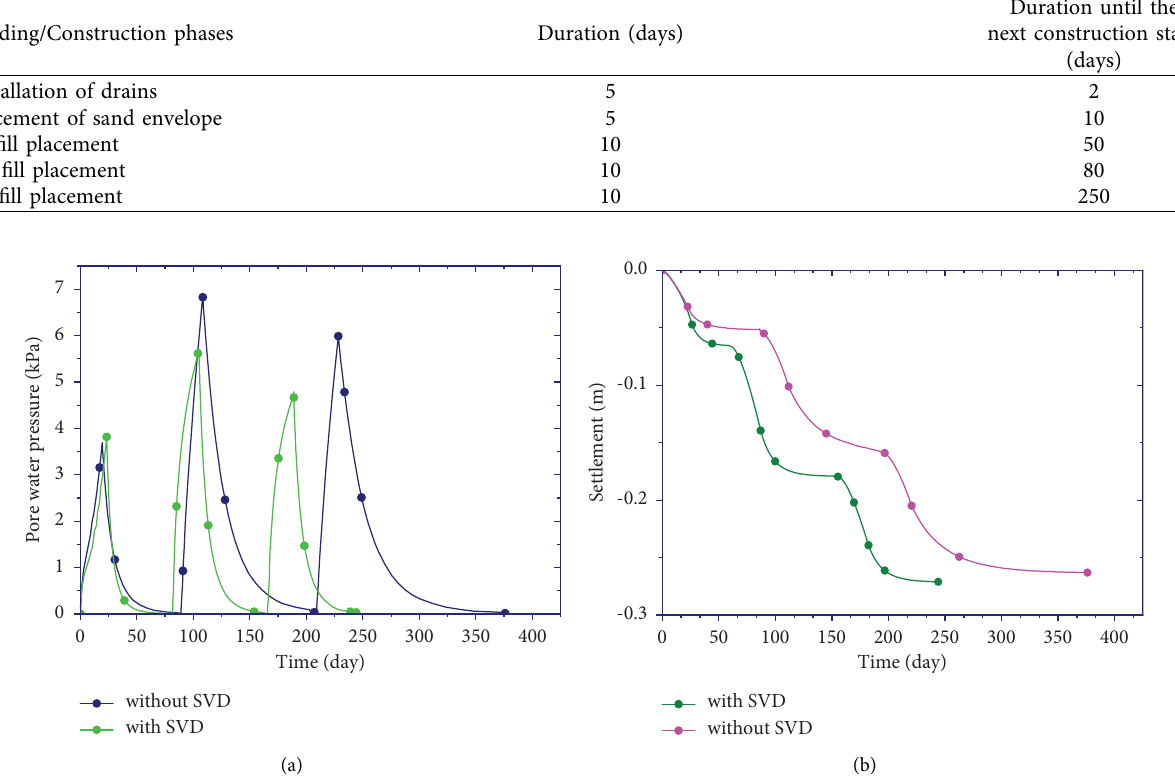
Figure 8: (a) Te efect of SVD on PWP under embankment fll (for D � 0.4m, S � 2.5m, and L � 8m). (b) Te efect of SVD on settlement (for D � 0.4 m, S � 2.5m, and D � 8m).